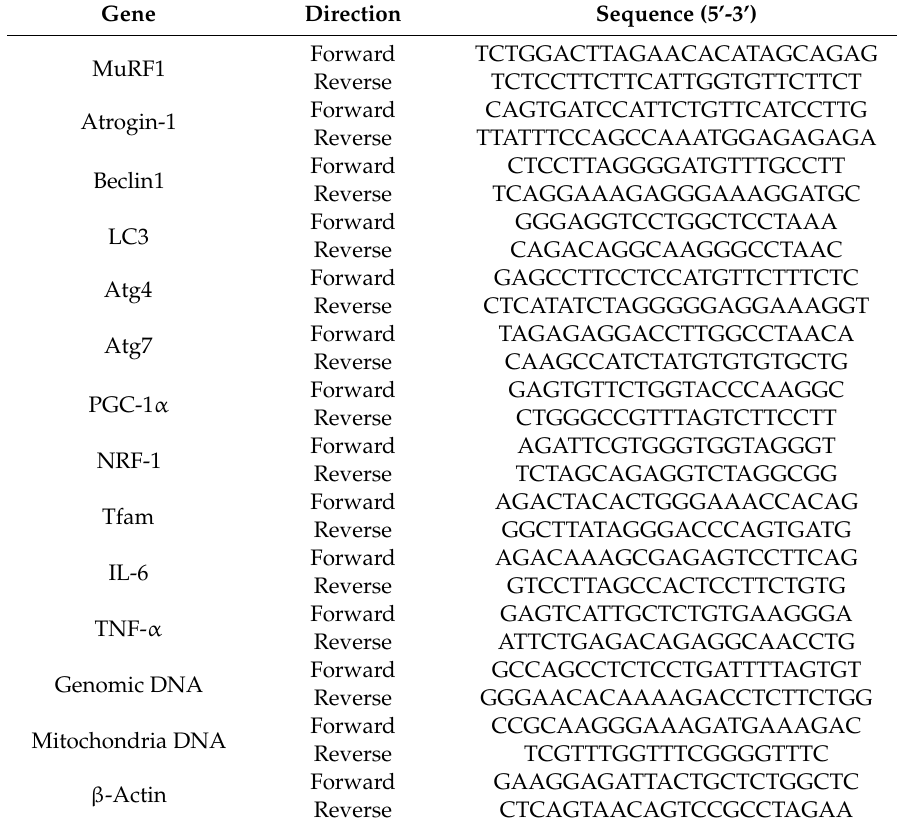
Table 1. The sequences of forward and reverse primers for target